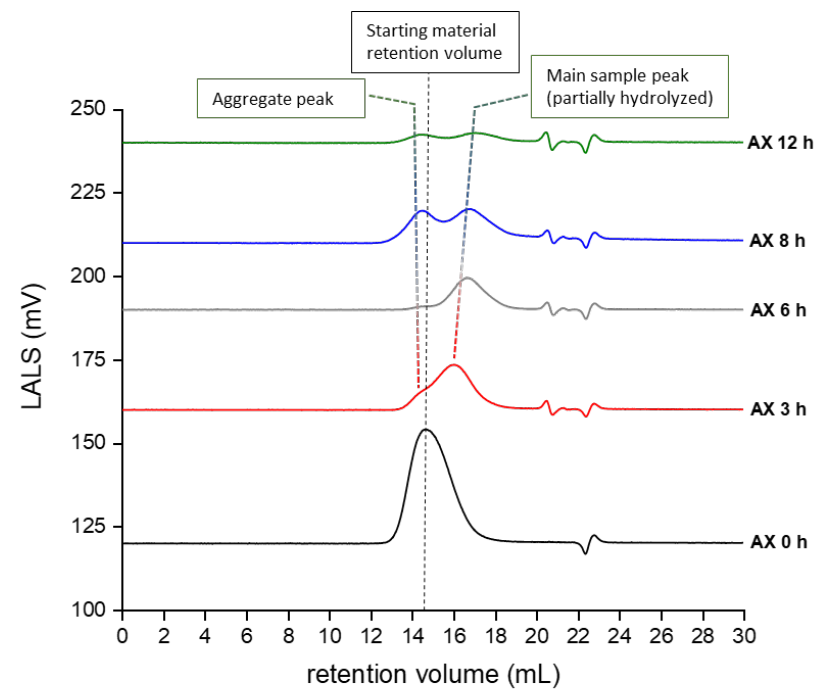
Figure 3. Low-Angle Light Scattering ( LALS) ignal of native (AX 0 h) and partially hydrolyzed AX (AX 3 – 12 h). After 3 h of treatment with HCl, a second peak was observed in the LALS signal,